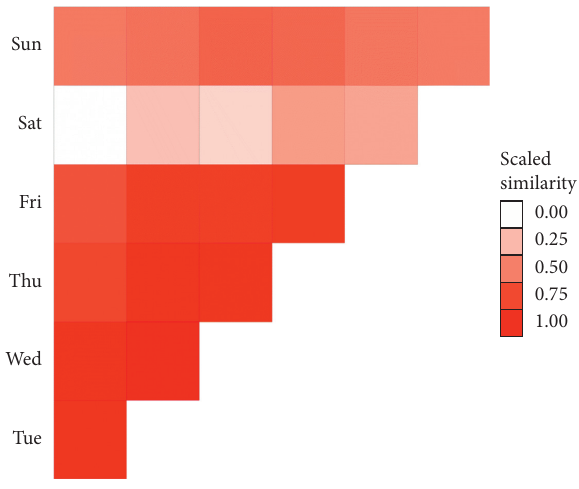
Figure 6: Similarities among different days in the same week.